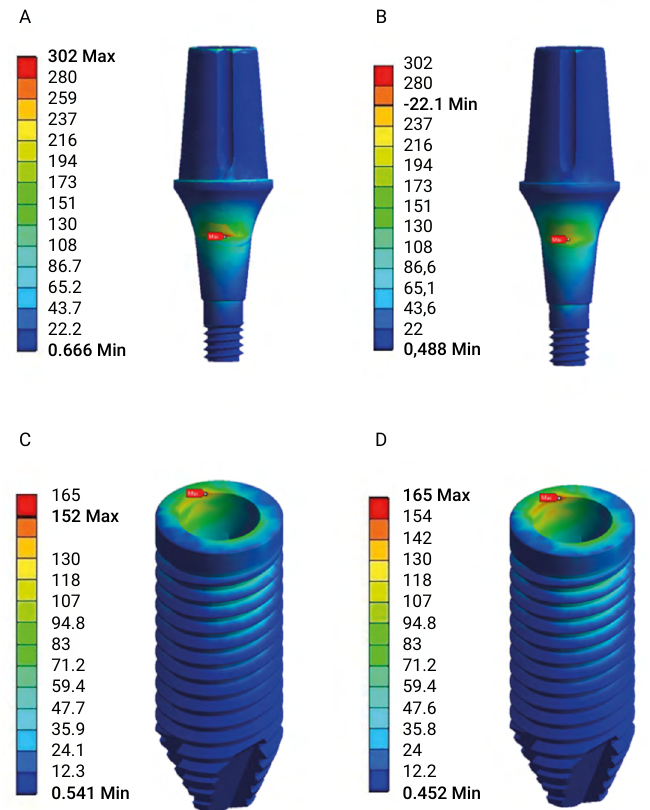
Figure 4. Stress distribution in the prosthetic abutment and implant (σ abutment of the model restored with a 65 µm (A) and 38 µm (B) cement layer showing the stress peak on the prosthetic abutment collar. Isometric view of the implant of the model restored with a 65 µm (C) and 38 µm (D) cement layer showing the stress peak on the corresponding abutment collar